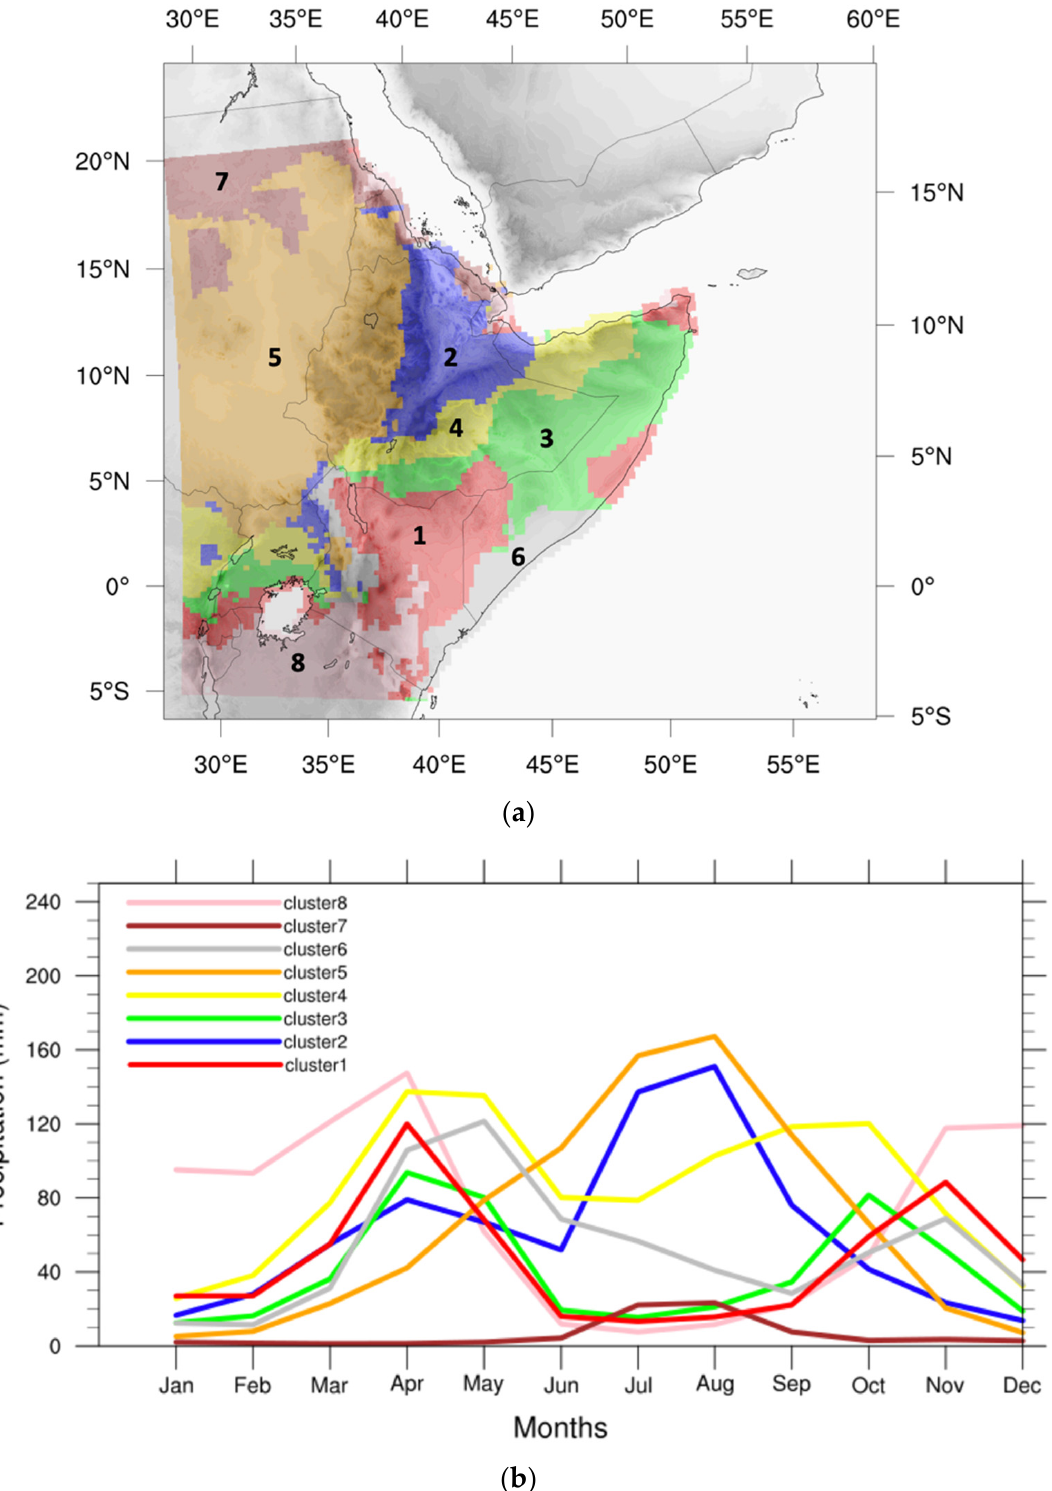
Figure 5. Map of the EA clusters from GPCC_Clim data ( a ) and corresponding precipitation annual cycles for each EA cluster ( b ).